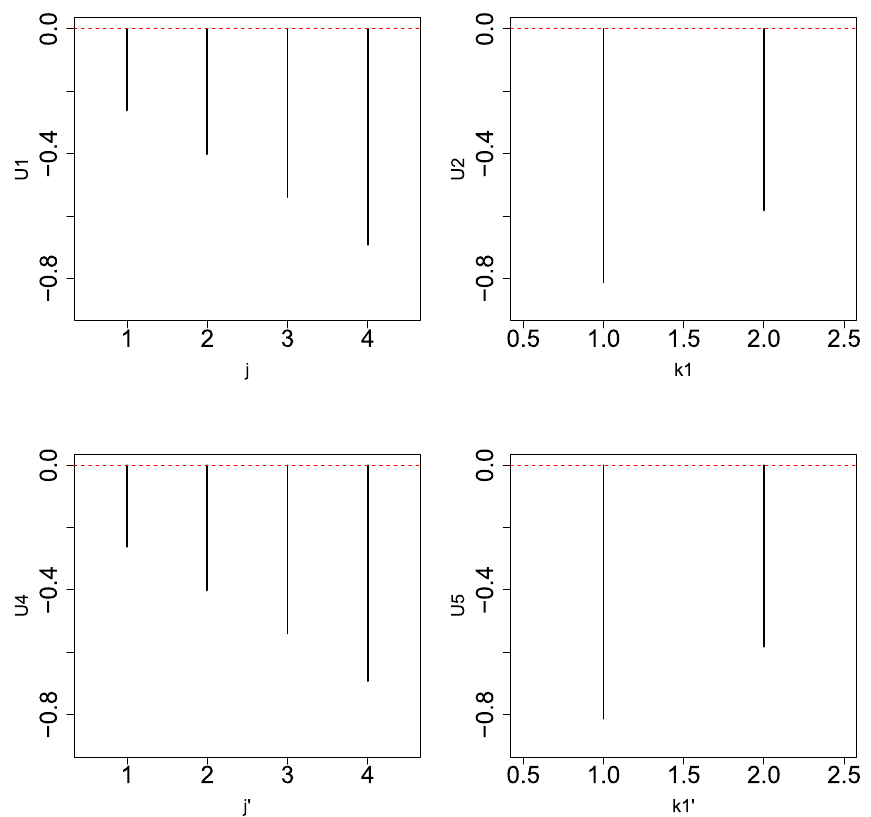
Figure 8. Singular value vectors obtained when KTD-based unsupervised FE was applied to the 2nd synthetic data set. Upper left: u 1 j , upper right: u 1 k 1 , lower left: u 1 j ′ , lower right: u 1 k ′ indicates baseline